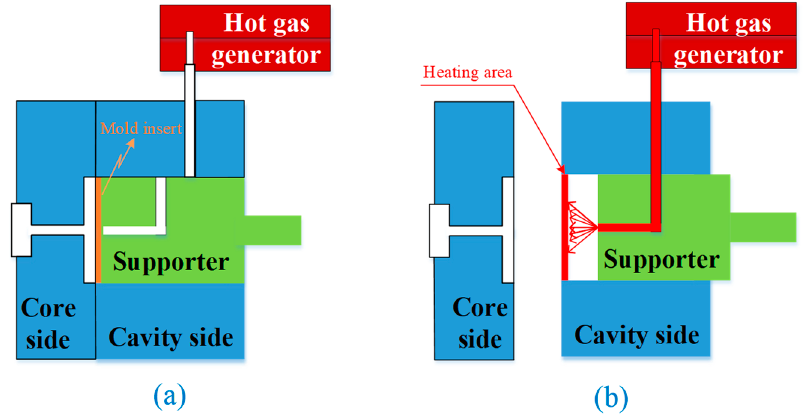
Figure 2. Mold position in the heating stage of the In-GMTC process. ( a ) Molding position. ( b ) Heating position.